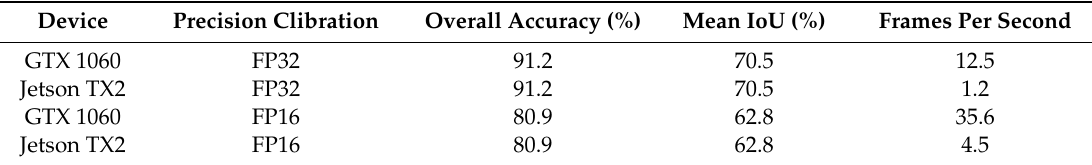
Table 2. Inference optimization in the desktop and the embedded devices.